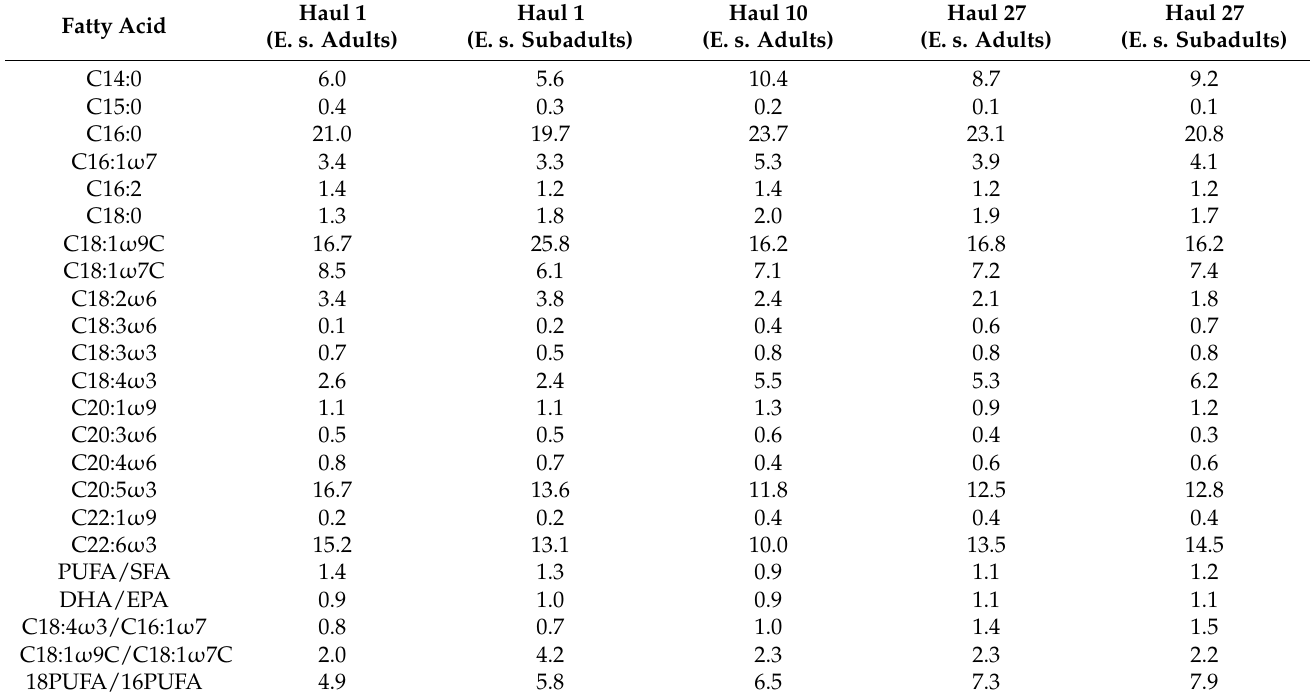
Table 4. Fatty acids classes and percent content found in E. superba individuals. At the bottom of the table the most relevant ratios, useful to characterize krill main diet, are reported. E. s. = Euphausia superba , PUFA = polyunsaturated fatty acids, SFA = saturated fatty acids, DHA = docosahexaenoic acid, EPA = eicosapentaenoic